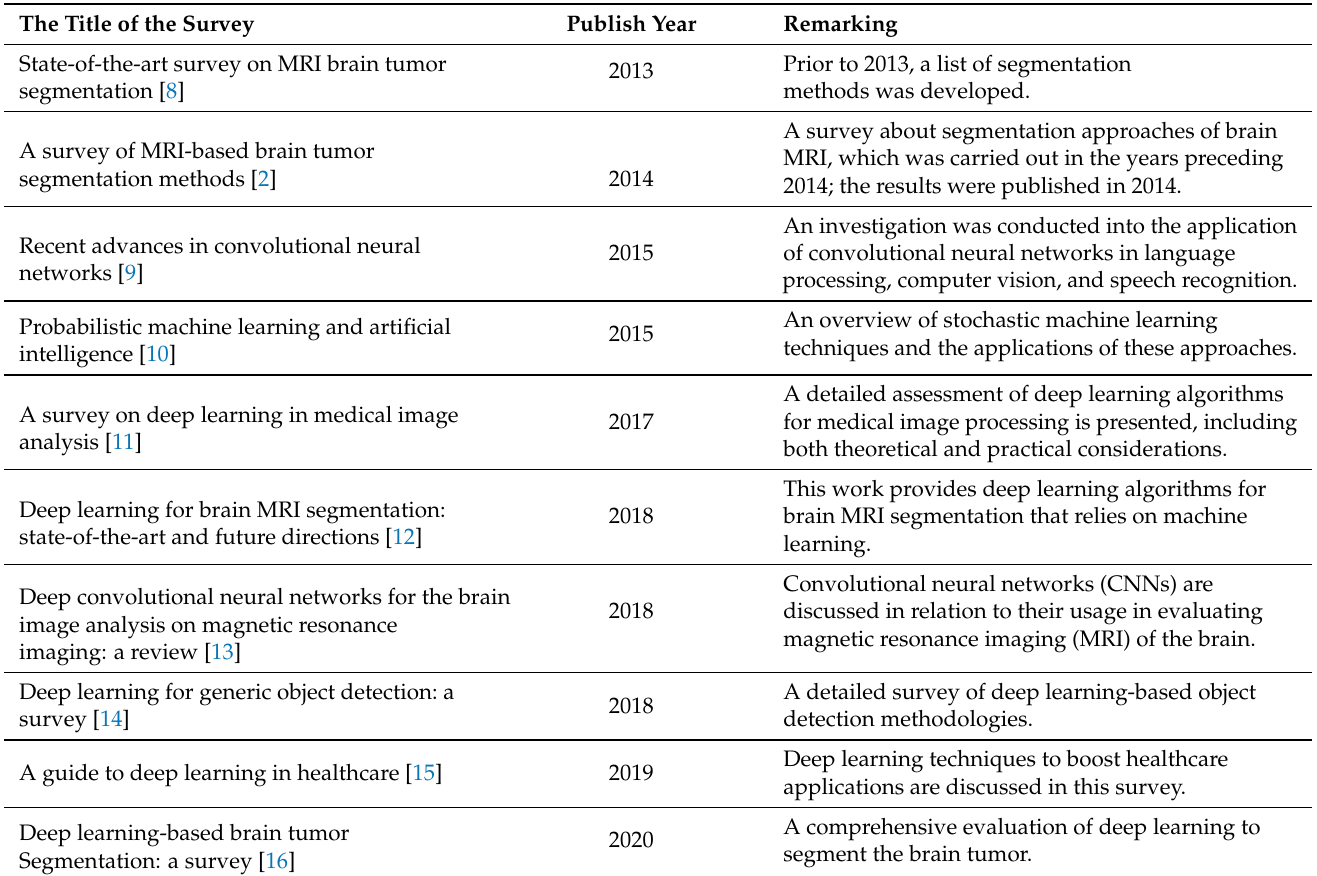
Table 1 introduces a summary of the current surveys. Table 1. The current surveys.